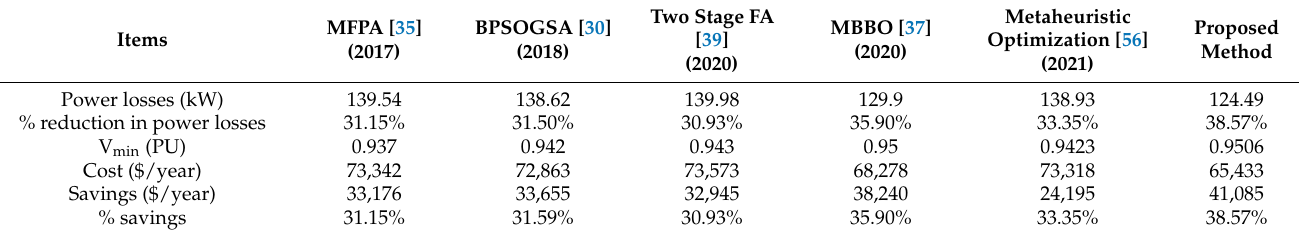
Table 4. IEEE 33 system with reconfiguration only.